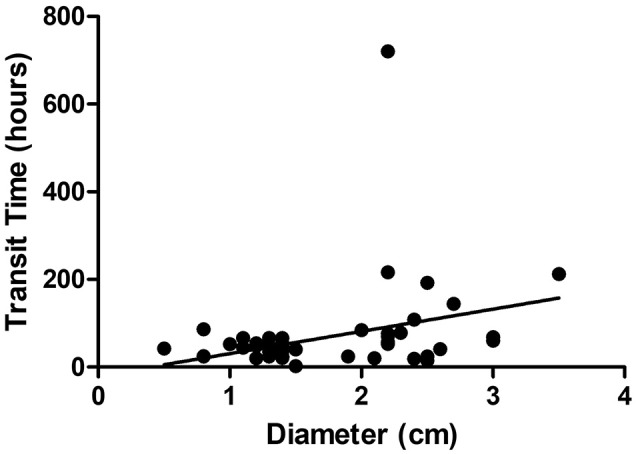
Linear regression analysis of the correlation between diameter and transit time in regularly foreign bodies.